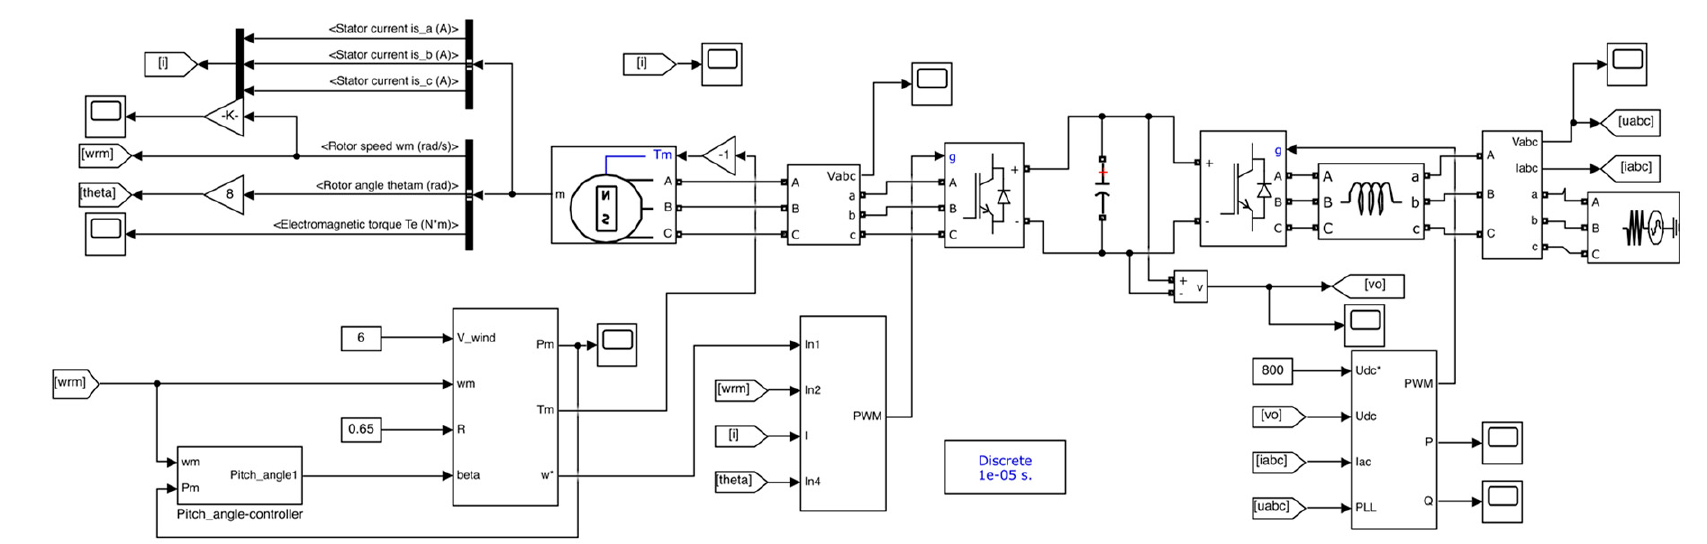
Figure 18. System block diagram.